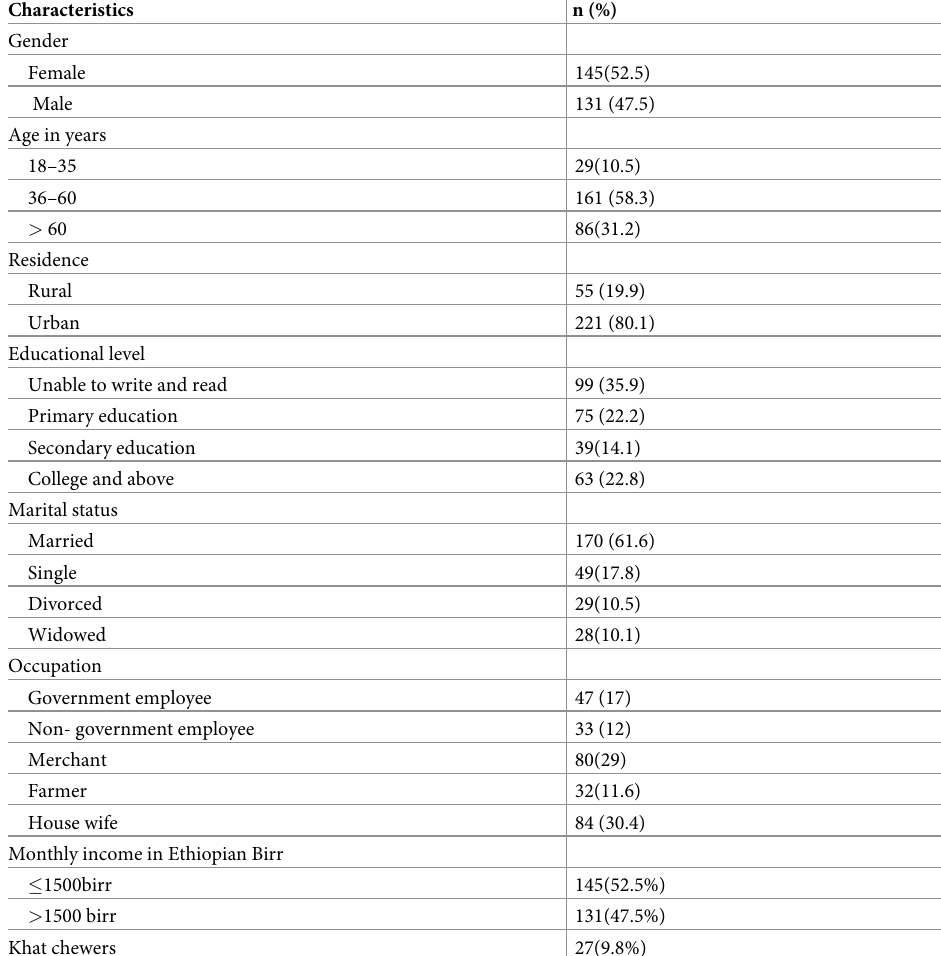
Table 1. Socio-demographic characteristics of hypertensive patients in ACSH, 2017 (n = 276).